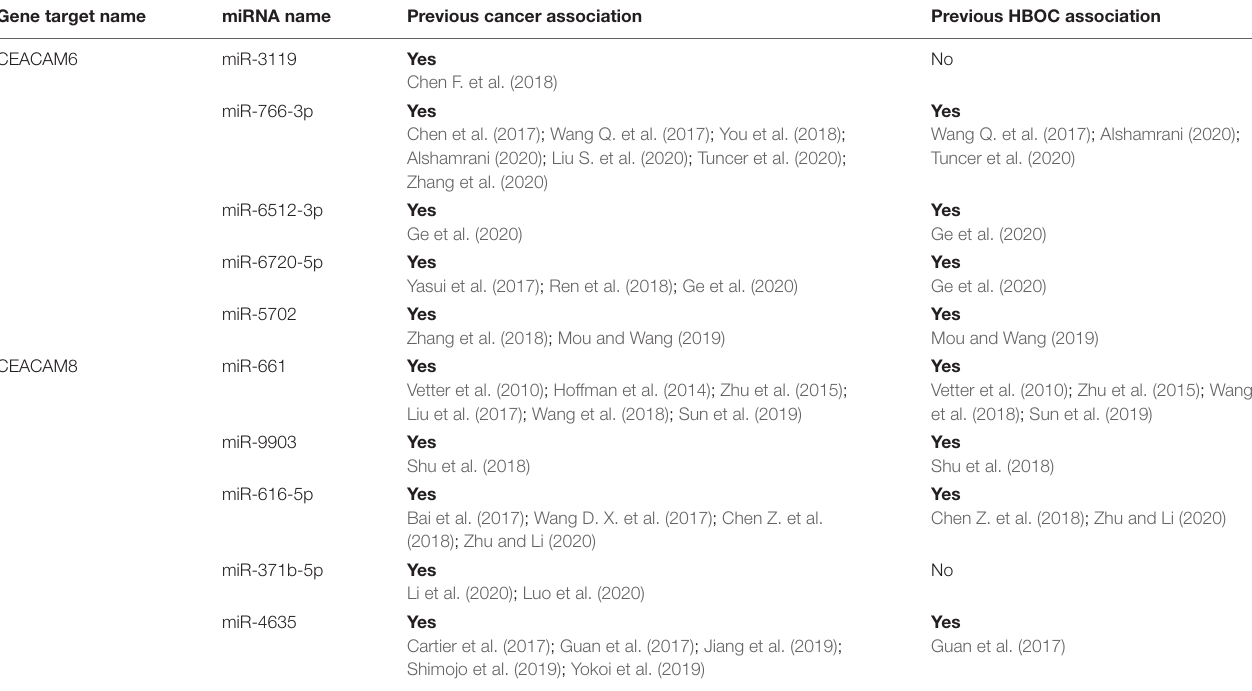
TABLE 4 | Top five miRNA binding sites for both CEACAM6 and CEACAM8 and previous cancer associations.